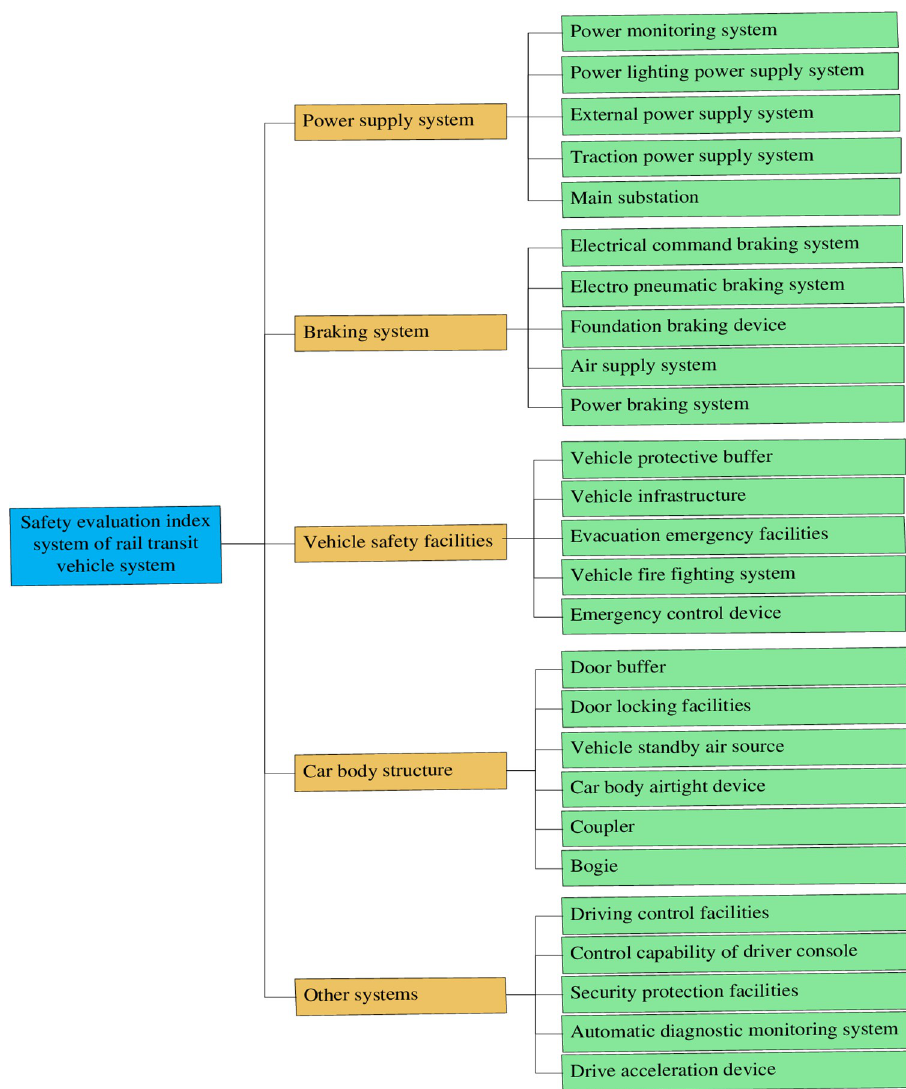
Fig 3. Safety evaluation index system of rail vehicle